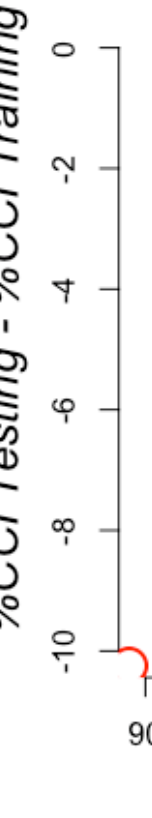
Figure 9. Learning efficiency on sampling training sets without redundancy. The percentage of correctly classified instances (CCI) for 360 testing sets ( X -axis) is plotted against the difference observed in these values for testing and training ( Y -axis). CCI corresponds to true predictions, including both positive and negative PPI. Therefore, 100% on the X -axes corresponds to not failing any prediction on the testing set and a 0 value on the Y -axis corresponds to no difference observed in the prediction between the training and the testing set. The best models are shown the top right corner. RCCs built using sidechains are otherwise represented by red circles or black squares.